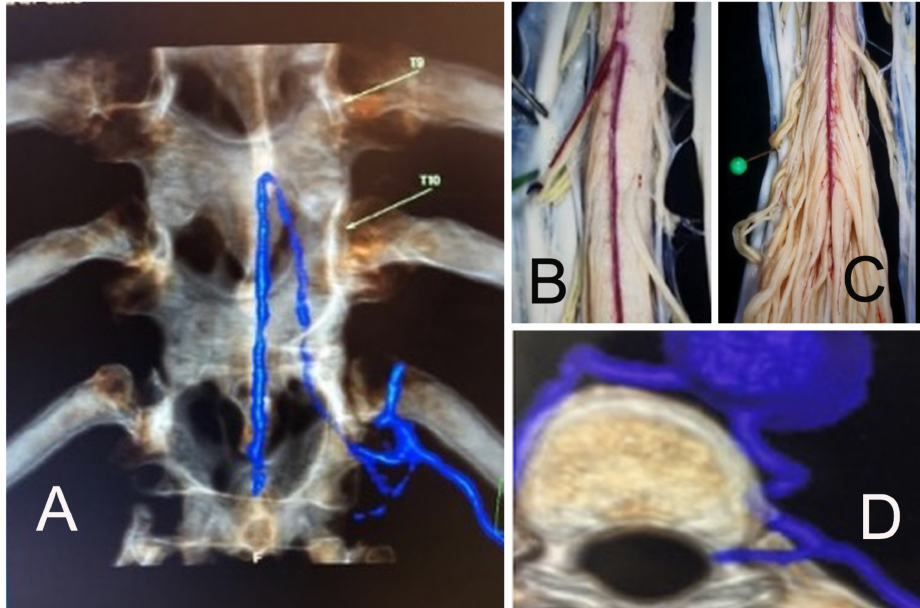
Figure 1. Computed Tomography (CT) angiography shows the entry foramen of the magna radicular artery or “Adamkiewicz” system in both coronal ( A ) and axial ( D ) cuts. A dissection of a cadaver spinal cord after wide longitudinal durotomy shows how the Magna Adamkiewicz system arises from a radicular artery ( B ) and supplies the majority of the thoracolumbar spinal cord and cauda equina ( C